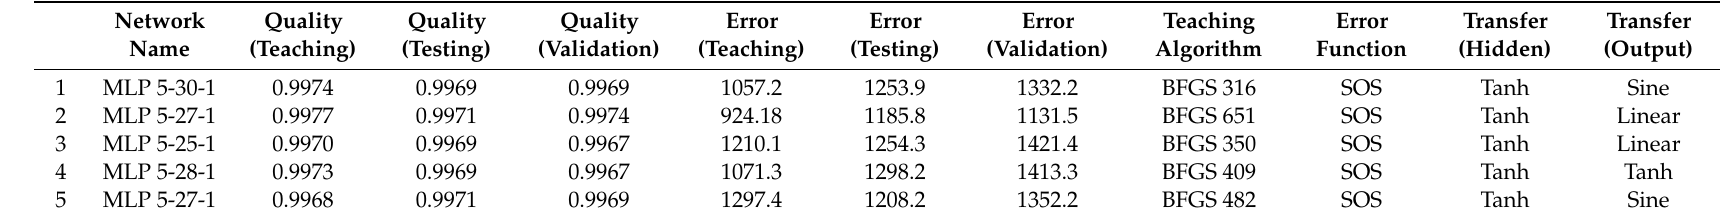
Table 3. Comparison of the best neural networks.